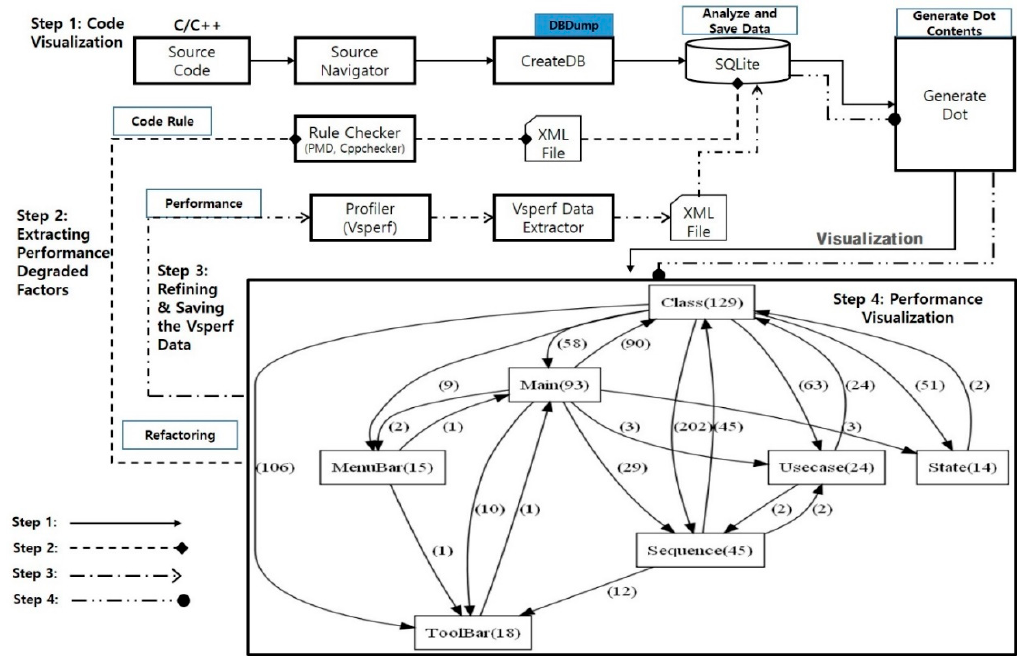
Figure 1. Performance improvement mechanism for procedural languages.